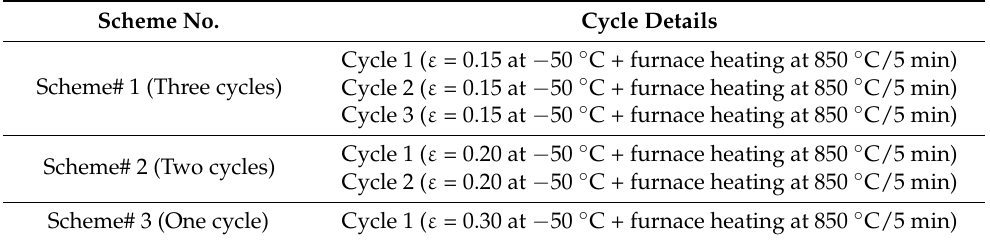
Table 1. Details of thermomechanical processing of 301 stainless steel samples. Scheme